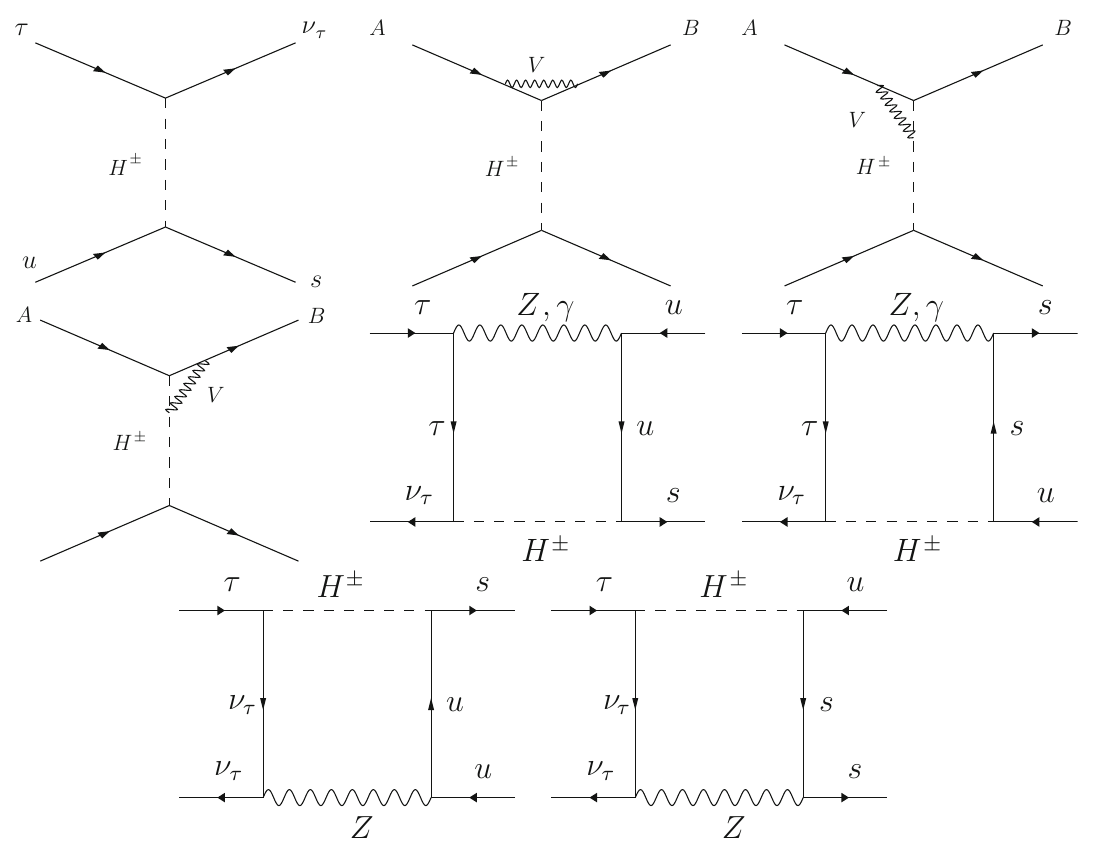
external lines, in the figures, to be understood as representing up and strange quarks. On the other hand when A and B are up and strange quarks, the other external lines in the figures are simply representing τ and ν